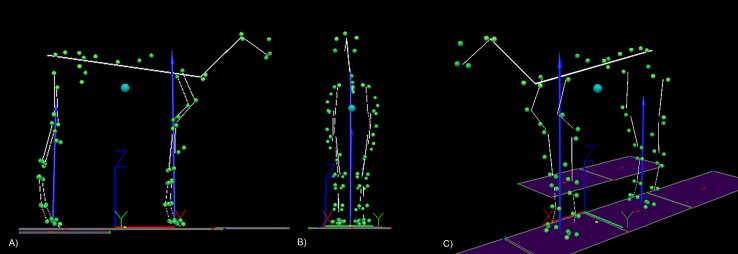
 An example of the 25 segment model developed for each horse.(A) Sagittal plane view, (B) frontal plane view, (C) oblique view. The blue sphere represents the position of the centre of mass (COM). The cranio-caudal location of the COM is projected on to the ground and is shown as a yellow dot between fore and hindlimbs. The blue arrows represent the resultant ground reaction force vectors for fore and hind limbs. The green spheres represent the location of anatomical markers attached to the horse and the yellow lines represent the model segments. The origin and global coordinate system for the laboratory is depicted by the XYZ axes that can be seen underneath the horse model.